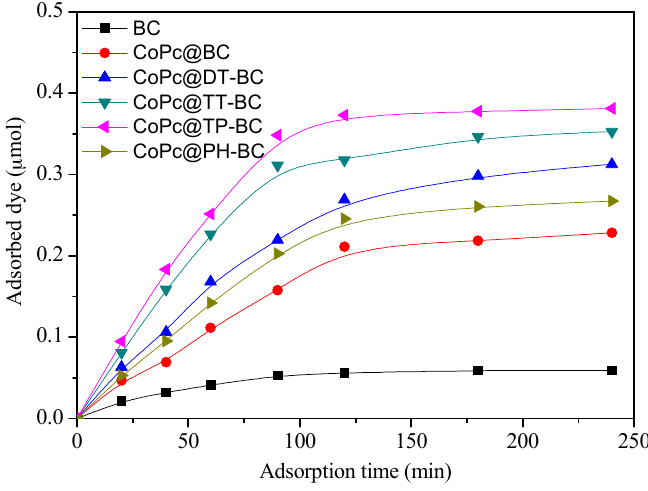
Figure 6. Adsorption of reactive red X-3B wastewater (initial concentration 100 μ M, pH = 2, T = 50 °C) with CoPc@s-BC (1 mg).